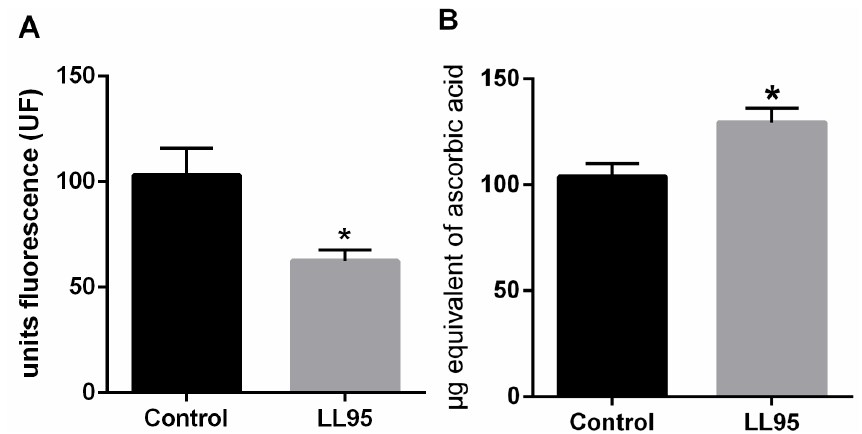
Figure 4. Effect of L. lactis LL95 in oxidative stress in hippocampus. L. lactis LL95 induced a decrease on levels of reactive species ( A ) and an increase in the ferric reducing / antioxidant power ( B ) on hippocampus in mice. Data are expressed as mean ± S.E.M. (n = 6). * p < 0.05 vs. control group.